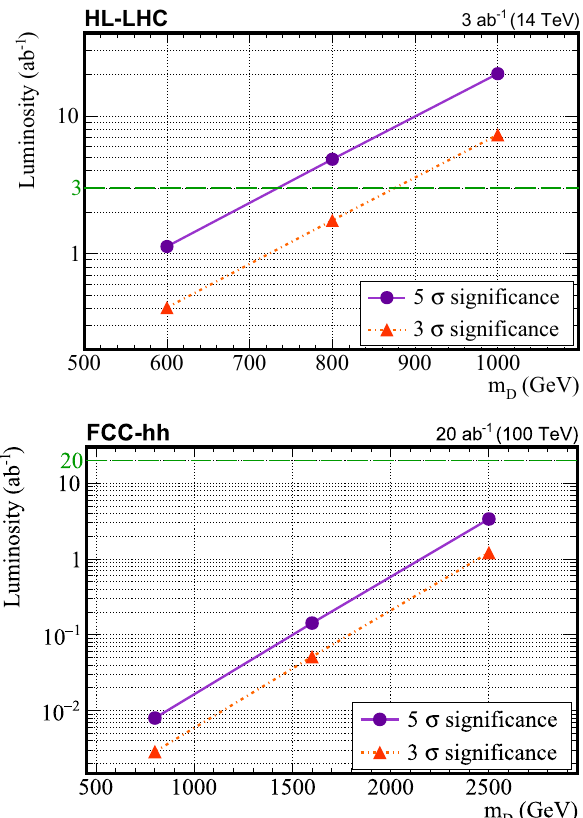
Fig. 10 The integrated luminosity needed for 3 σ observation and 5 σ discovery as a function of D quark mass for HL-LHC (top) and FCC-hh (bottom) Table 6 Upper limit on D quark masses for 3 σ observation and 5